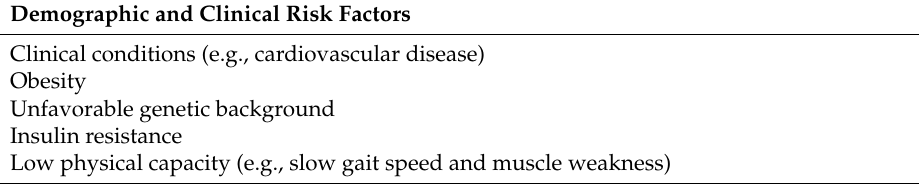
Table 1. Prioritized physical and environmental risk factors for age-associated cellular decline (AACD) (in rank order determined by the interdisciplinary expert panel).